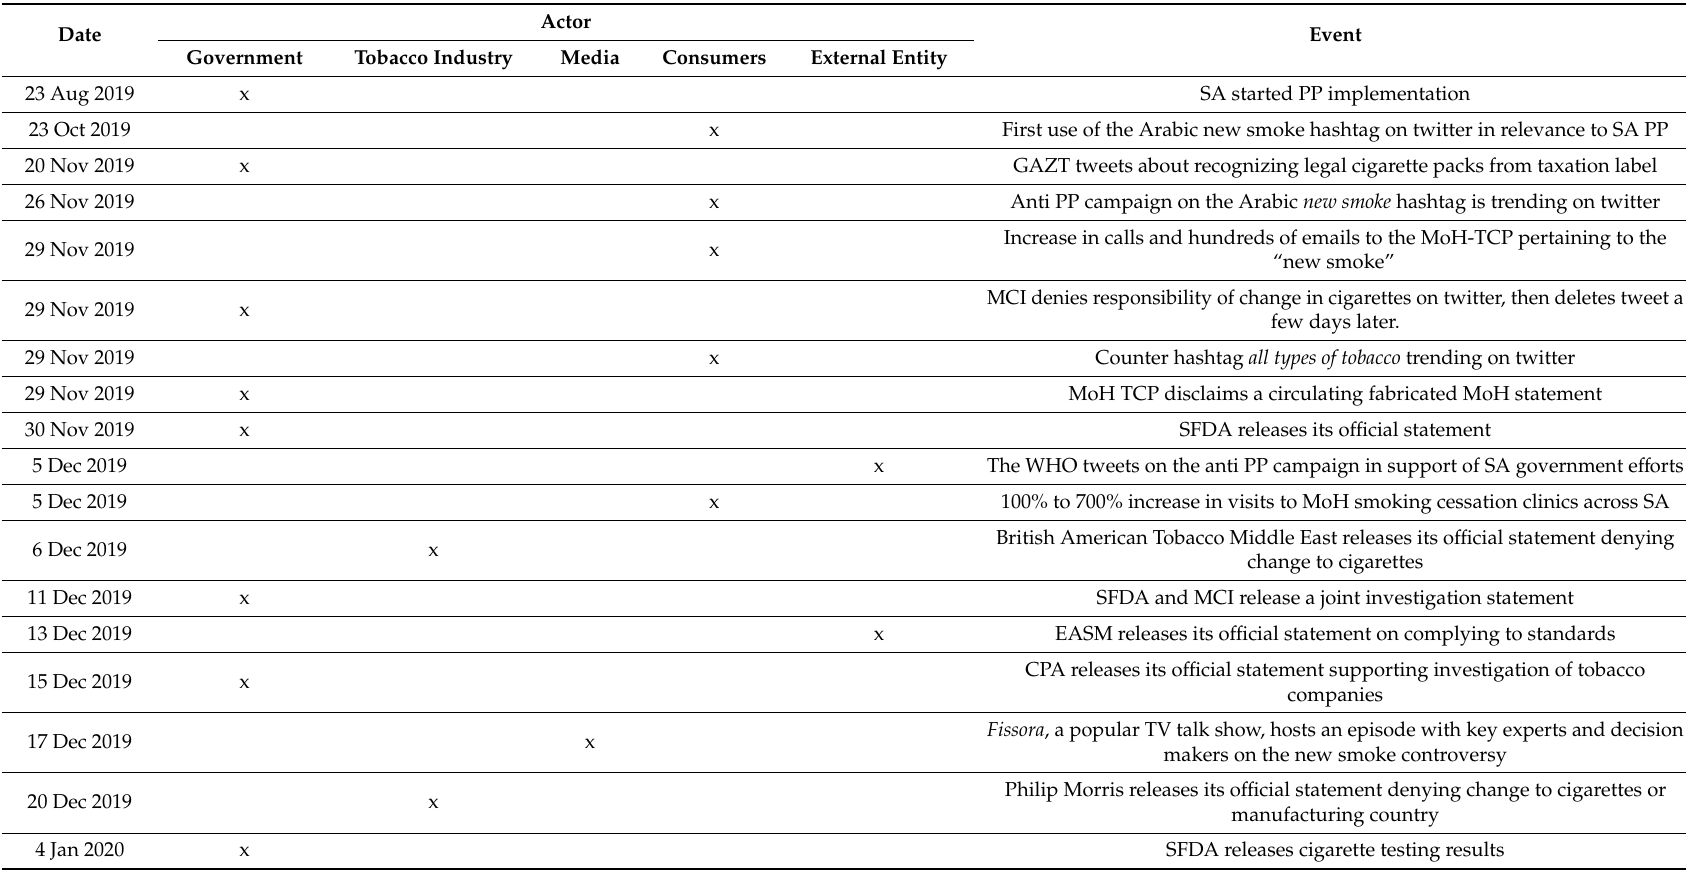
Table 1. Plain packaging and counter campaign